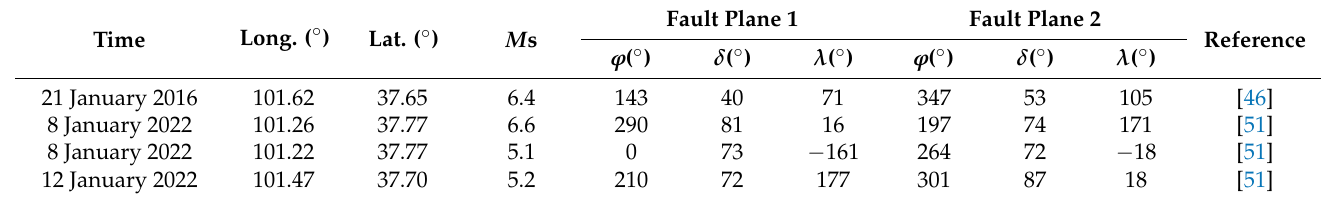
Table 1. Focal mechanism solutions of the major earthquakes around